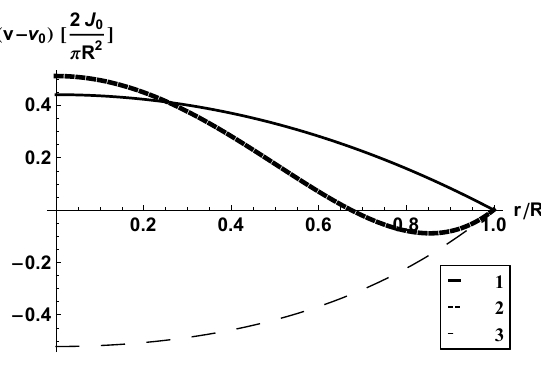
Figure 3. The radial velocity profile for the three numbered points of Figure